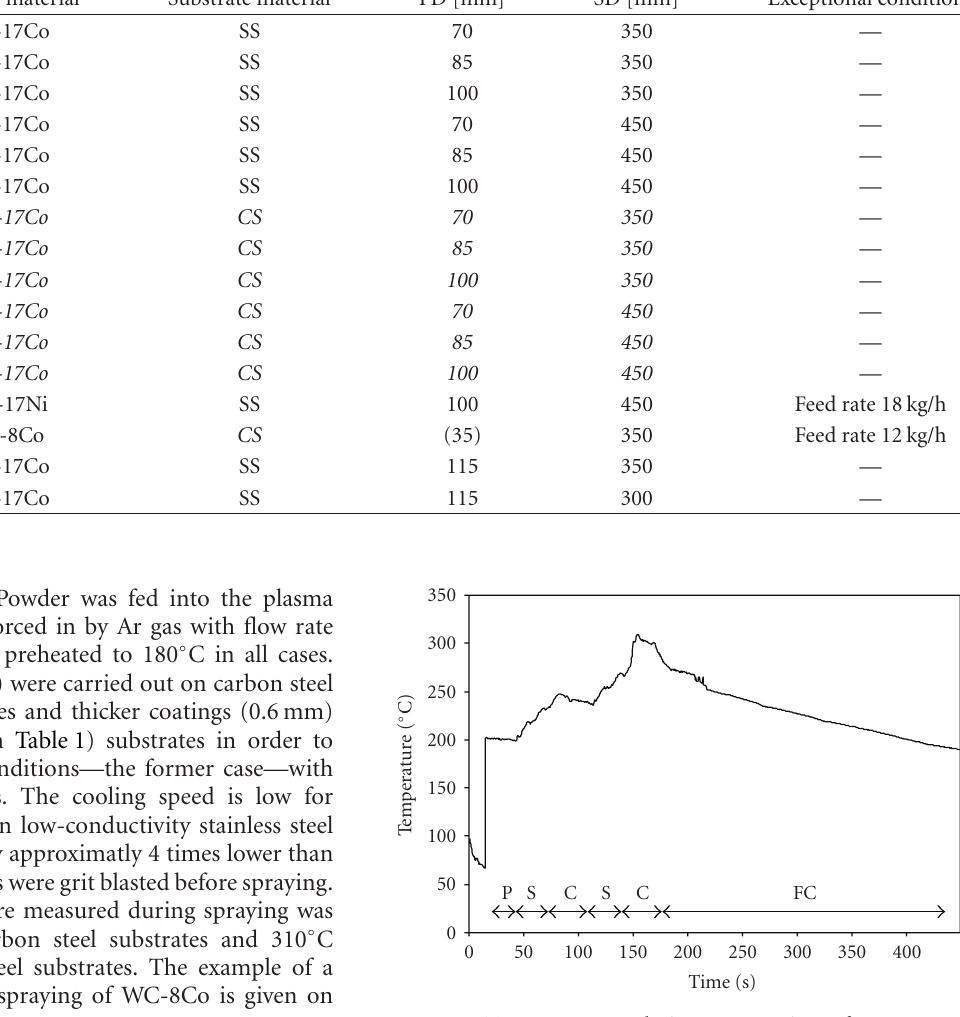
into all objects with size of 3 microns or more. For a better description of the size distribution of free flight particles (FFP), collected by placement of Ar-filled container instead of a substrate, certain additional criteria were introduced. (i) “Equivalent diameter” (ED) represents their size distribution (approximation at 2D projection). (ii) “Circularity” (CIR) describes the shape of particles when “1” represents a perfect circle and “0” the linear projection; it is calculated for at least 10 images. “Maximal CIR” (CIR max ) is then a parameter used for distinction between samples; small CIR max indicates rather elongated shapes while high CIR max characterizes good spheroidization of